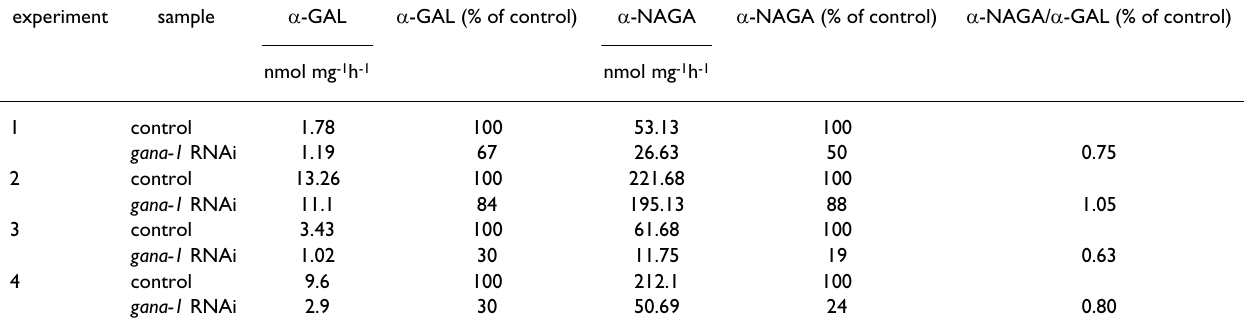
Table 1: α -GAL and α -NAGA activities after gana-1 RNAi. The table shows a proportional parallel decrease of both enzymatic activities ( α -GAL and α -NAGA) after gana-1 RNAi compared to controls. experiment